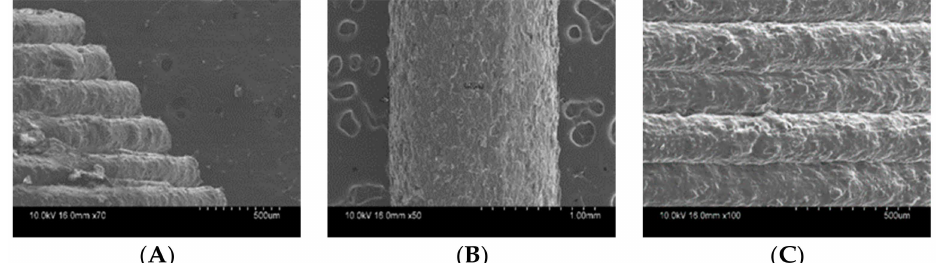
Figure 4. SEM image of filament and tablets. Outer surface of filament ( A ), side view of top layer ( B ), and center view of di ff erent layers ( C